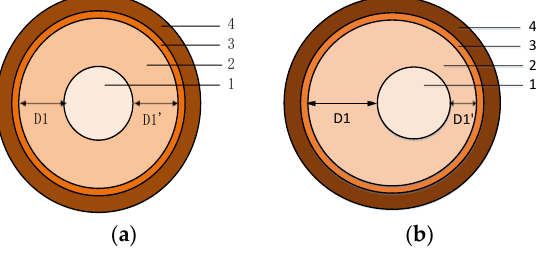
Figure 5. Cable cross-section diagram: ( a ) normal, ( b ) eccentricity.